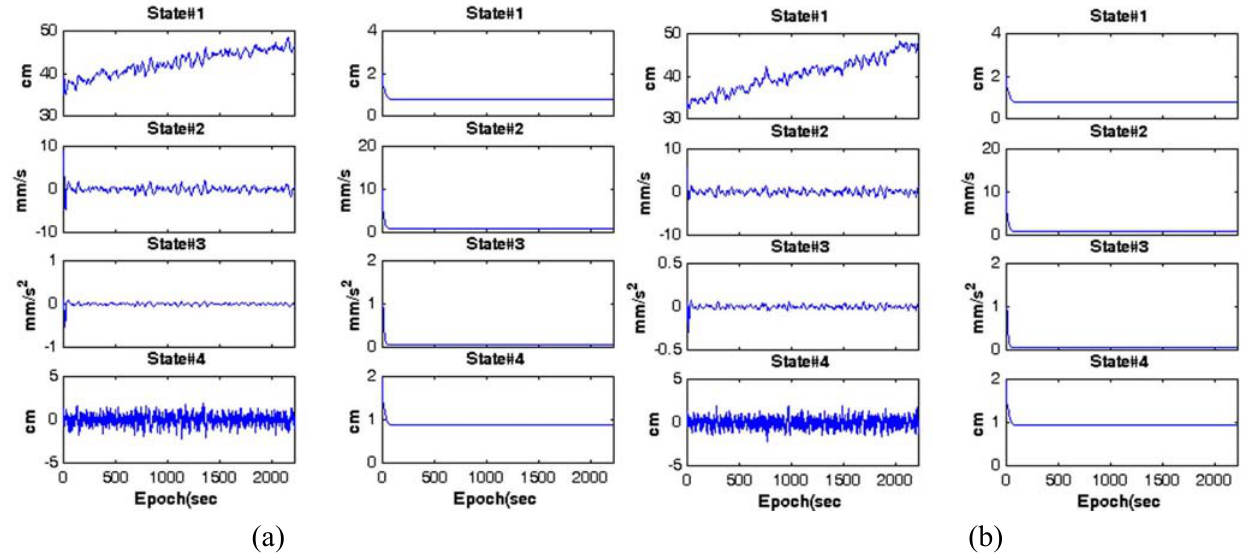
Figure 6. Impact of Kalman filtering in the estimation of the GPS baseline-dependent errors of SV8(CASE I).